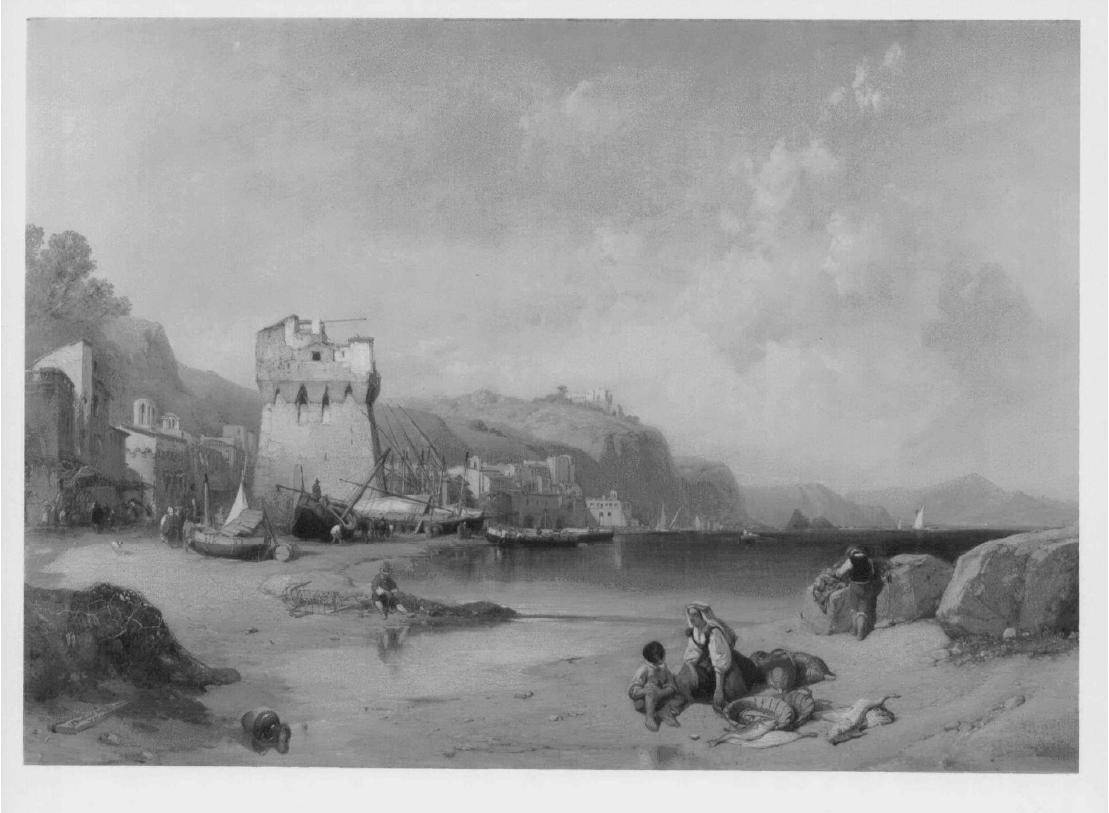
Figure 2. Clarkson Stanfield (1793–1867), A View of Vietri in the Gulf of Salerno, 1840; oil on canvas Coll. Royal Collection Trust/© Her Majesty Queen Elizabeth II